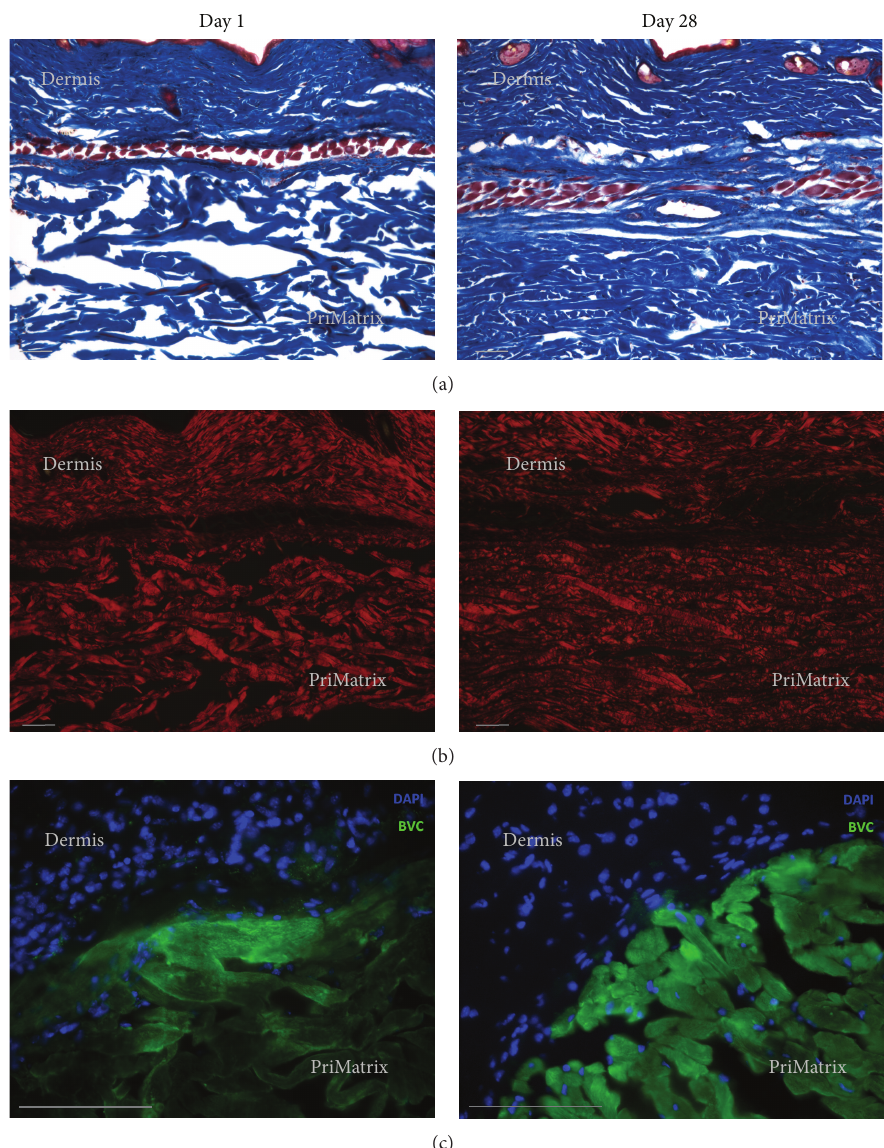
Figure 3: Characterization of collagen remodeling. Representative day 1 and day 28 images of PriMatrix implant and overlying dermis following trichrome (a) and picrosirius red staining (b), illustrating an increased density and organization of implants over time. (c) Representative high power images of immunofluorescence bovine collagen staining at days 1 and 28, demonstrating the persistence of PriMatrix derived fibers during the remodeling process. Scale bar is 100 𝜇 m for all images. BVC: bovine collagen; DAPI: nuclear